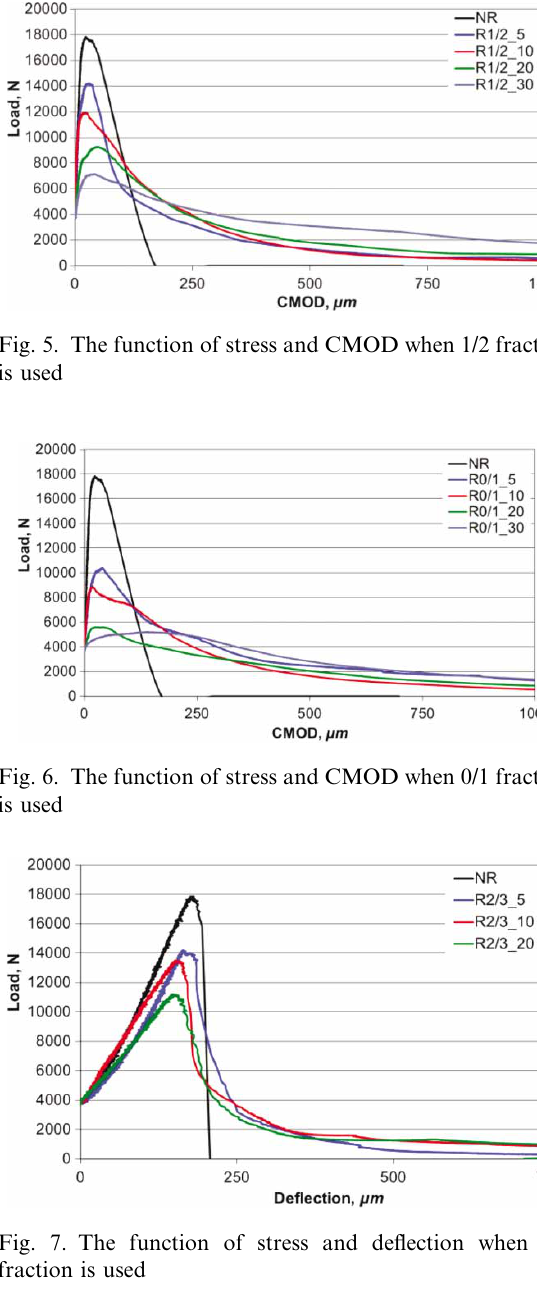
Fig. 8. The function of stress and deflection when 1/2 fraction is used